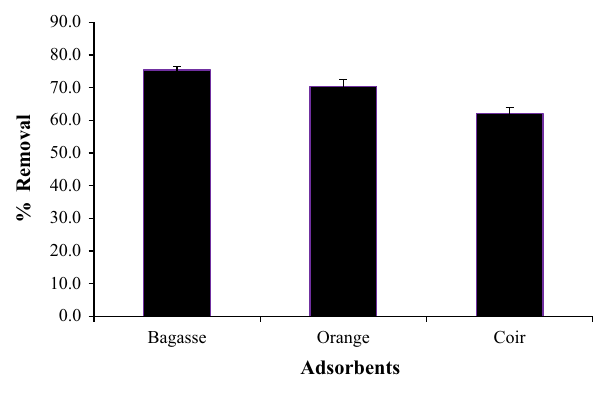
Fig. 1 Adsorption efficiency of different agrowastes at room tempera- ture (25 ± 3 °C), ± SD shown by error bar